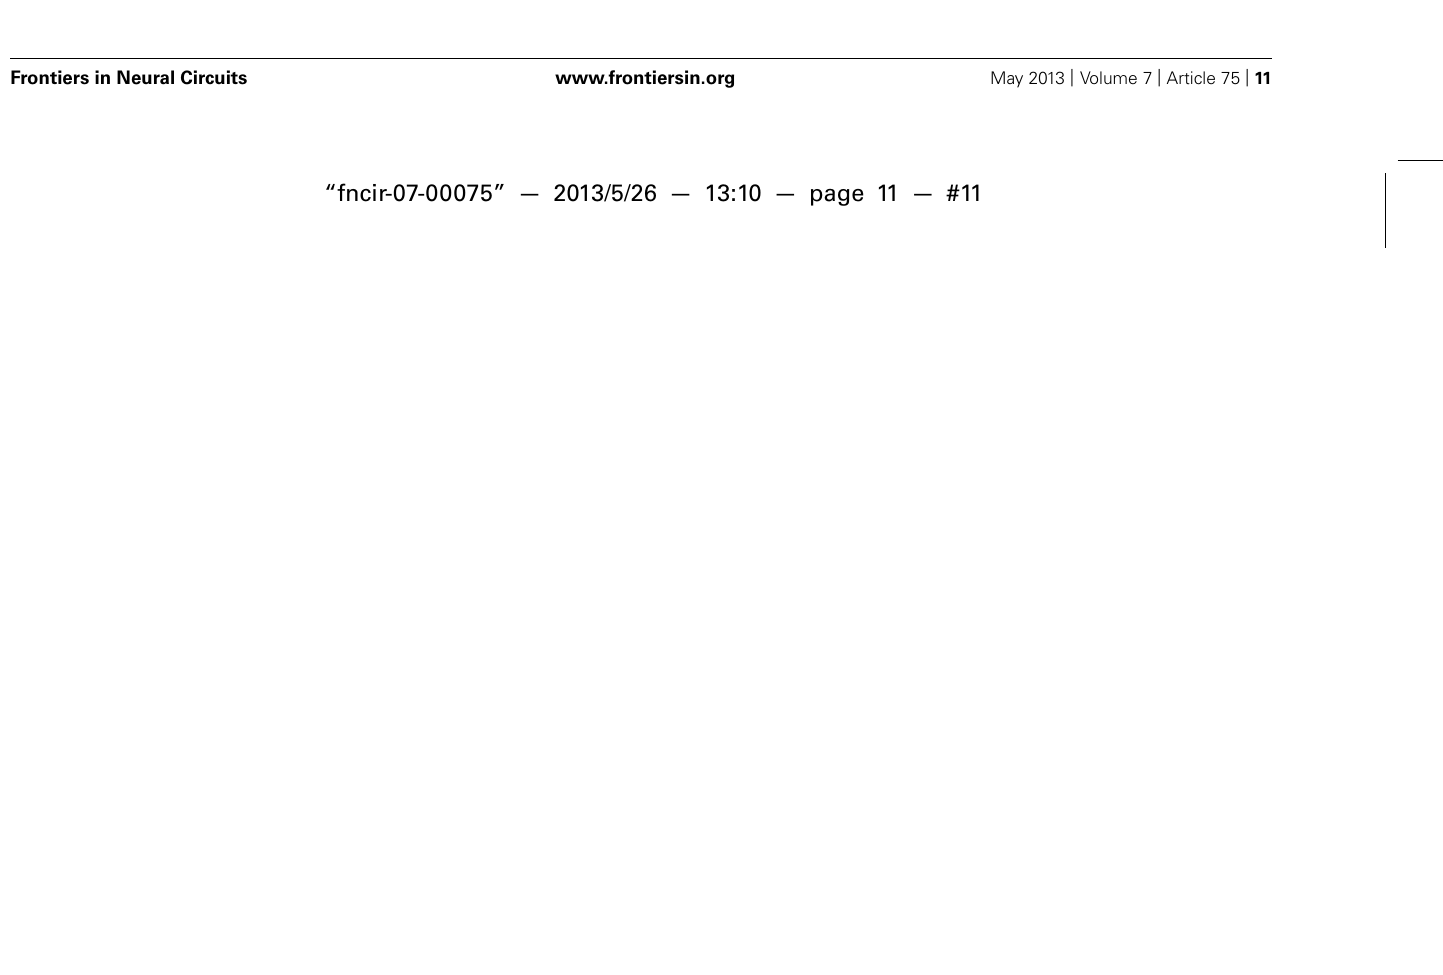
projection neurons, because their apical dendrites were short and the basal dendrites were abundant as reported previously (Zhang and Deschênes, 1997). In contrast, L6 + CTNs were taller and more slender than L6 − neurons. (O,P) It was examined whether each axon bouton of the intracortical collaterals was in close apposition to the retrogradely labeled CTN dendritic spines (large arrowheads) or not (double arrowheads). (Q,R) In addition, 77% of those appositions were electron-microscopically confirmed to form asymmetric synaptic contacts with the labeled spines (small arrowheads). The reaction products of retrograde labeling are indicated by small arrows. AT, labeled axon terminals; Den, dendritic profile; Sp, spine. Modified from Figures 1, 2, and 4 ofTanaka etal. (2011b). Scale bar in (B (cid:4)(cid:4) ) applies to (B–B (cid:4)(cid:4) ) , that in (H) to (E–H) , that in (N) to (J–N) , that in (N (cid:4) ) to (M (cid:4) ,N (cid:4) ) , that in (P) to (O,P) , and that in (R) to (Q,R)